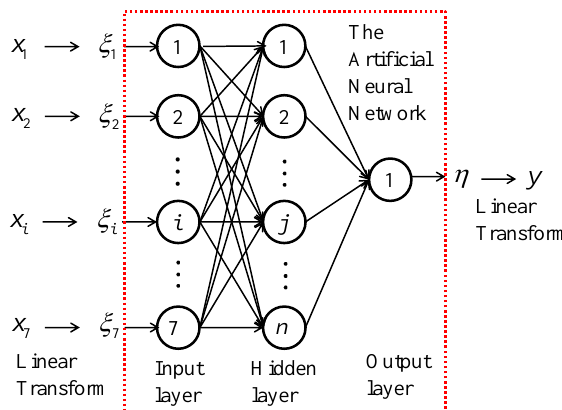
Table 1. The ranges of the inputs and the output in the raw data [12].